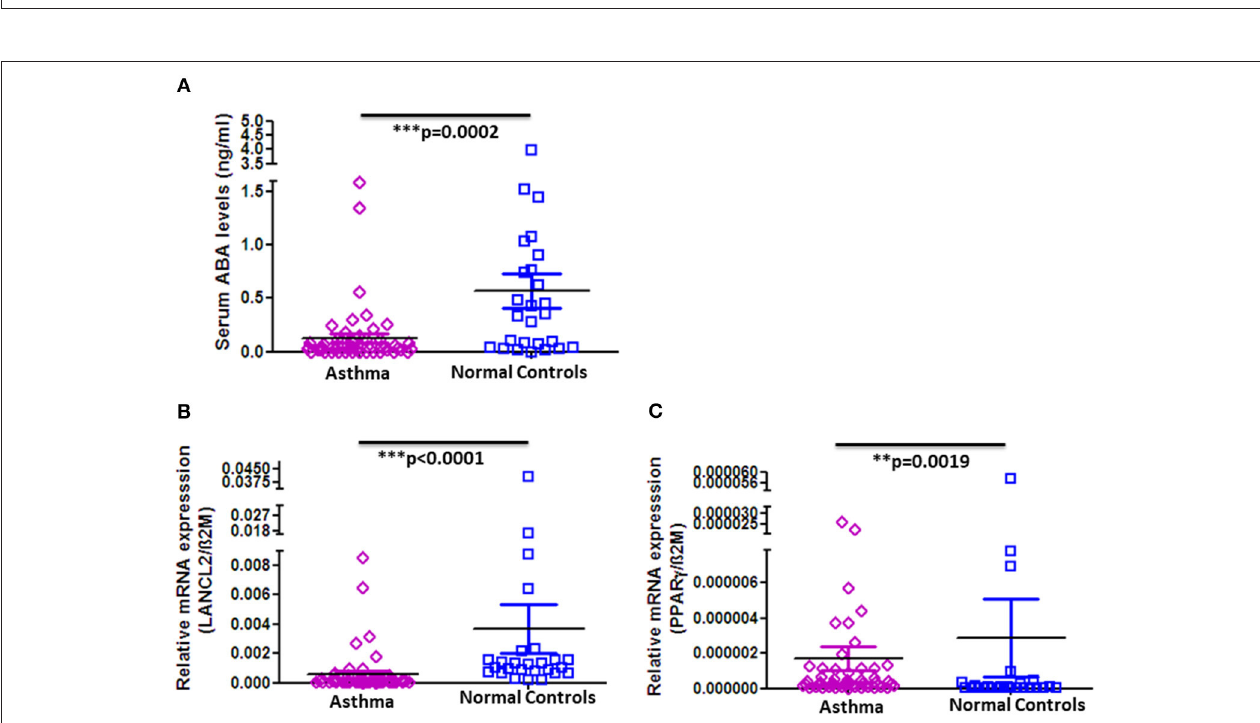
FIGURE 3 | ABA serum levels and LANCL2 and PPAR- γ gene expression on blood cells in asthma patients and controls. (A) Circulating serum levels of ABA in asthma patients ( n = 52) and age- and gender-matched controls ( n = 26). Blood cell gene expression of (B) LANCL2 and (C) PPAR- γ in asthma patients ( n = 52) and age- and gender-matched controls ( n = 26). The individual dots represent data obtained from individual subjects. Statistical analysis was done by either nonparametric Mann–Whitney test or unpaired Student t -test.